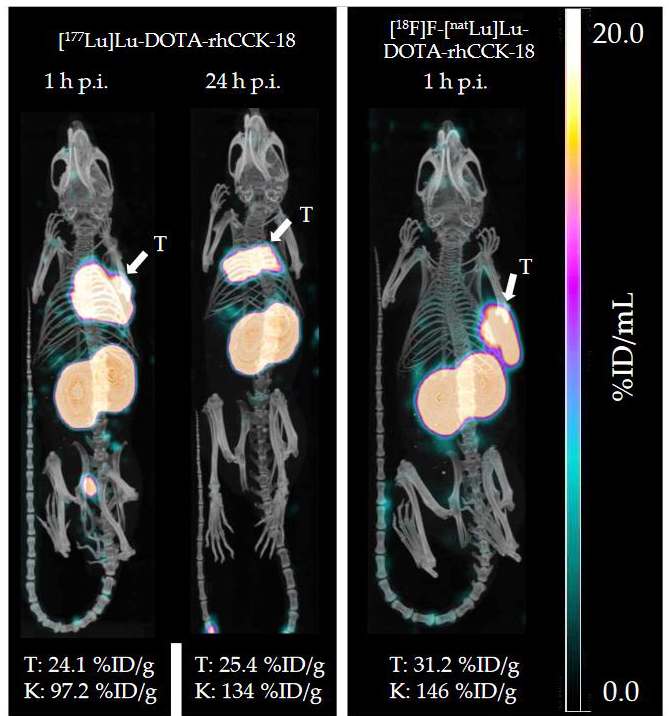
Figure 5. Representative µ SPECT/CT images of [ 177 Lu]Lu-DOTA-rhCCK-18 at 1 and 24 h p.i. ( left ) and µ PET/CT image of [ 18 F]F-[ nat Lu]Lu-DOTA-rhCCK-18 at 1 h p.i. ( right ) in AR42J tumor-bearing CB17- SCID mice (100 pmol each). Tumors (T) are indicated by white arrows. Kidney (K) and tumor (T) values are depicted at the bottom.